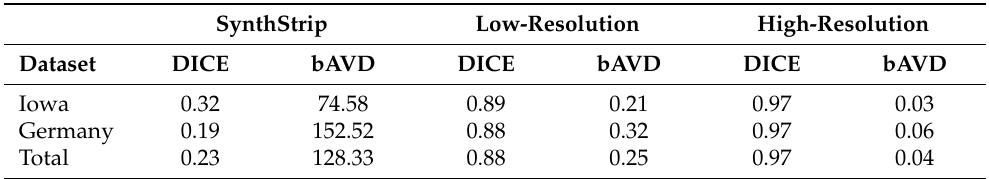
Table 3. Accuracy evaluation for SnthStrip, low-resolution, and high-resolution brainmask models. SynthStrip failed to perform with minipig data. The low-resolution model performed well in terms of both DICE and bAVD metrics, proving its robust brain position estimation using severely down- sampled data. The high-resolution model achieved very high accuracy for both metrics, supporting two-step brainmask